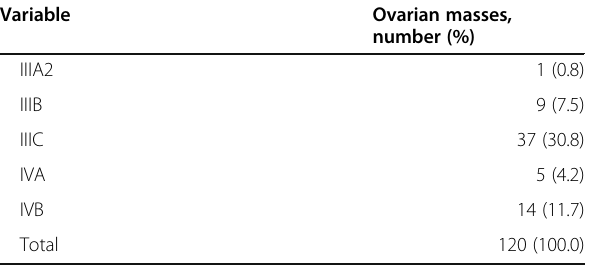
FIGO International Federation of Gynecology and